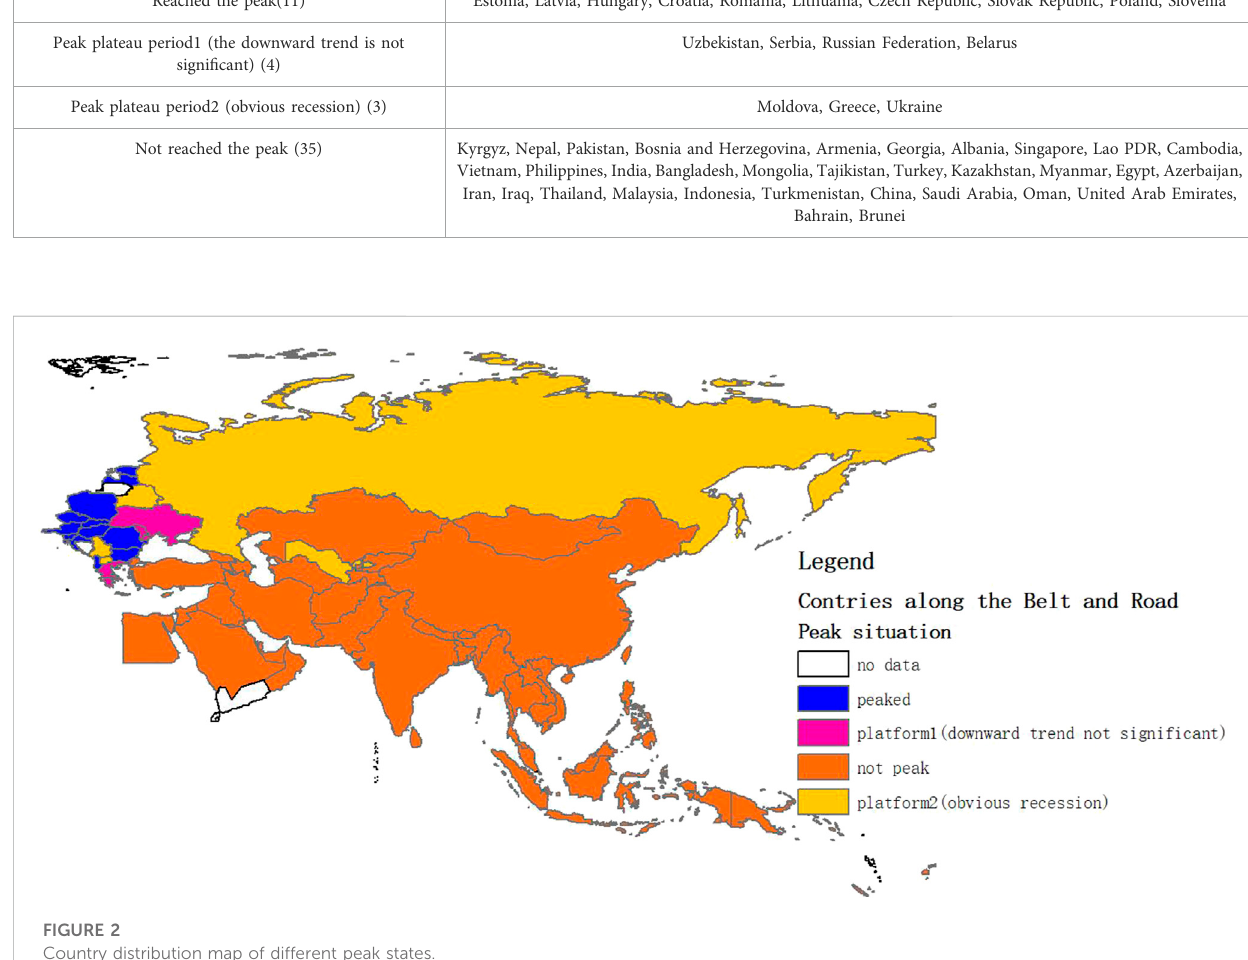
TABLE 1 List of countries with different peak status. Group